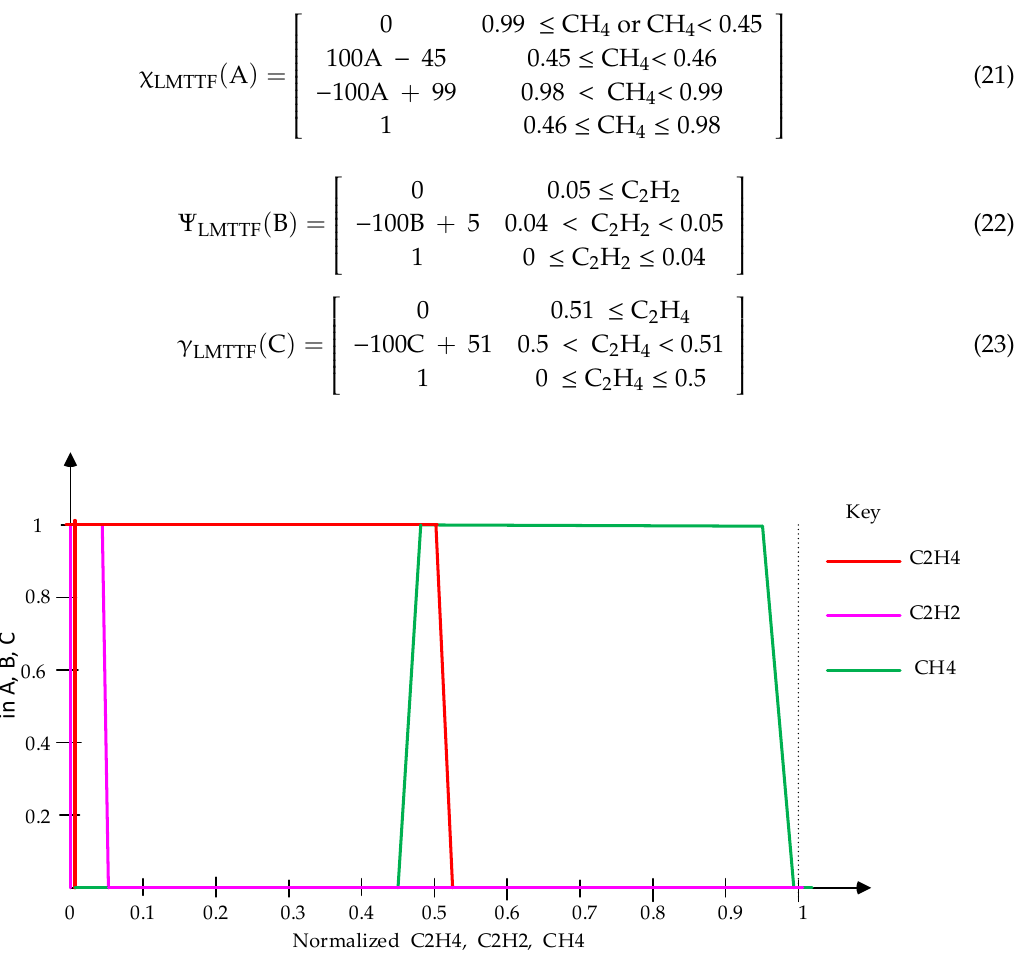
Figure 5. Fuzzy membership functions for analyzing the presence of low and medium-temperature thermal faults (LMTTF).